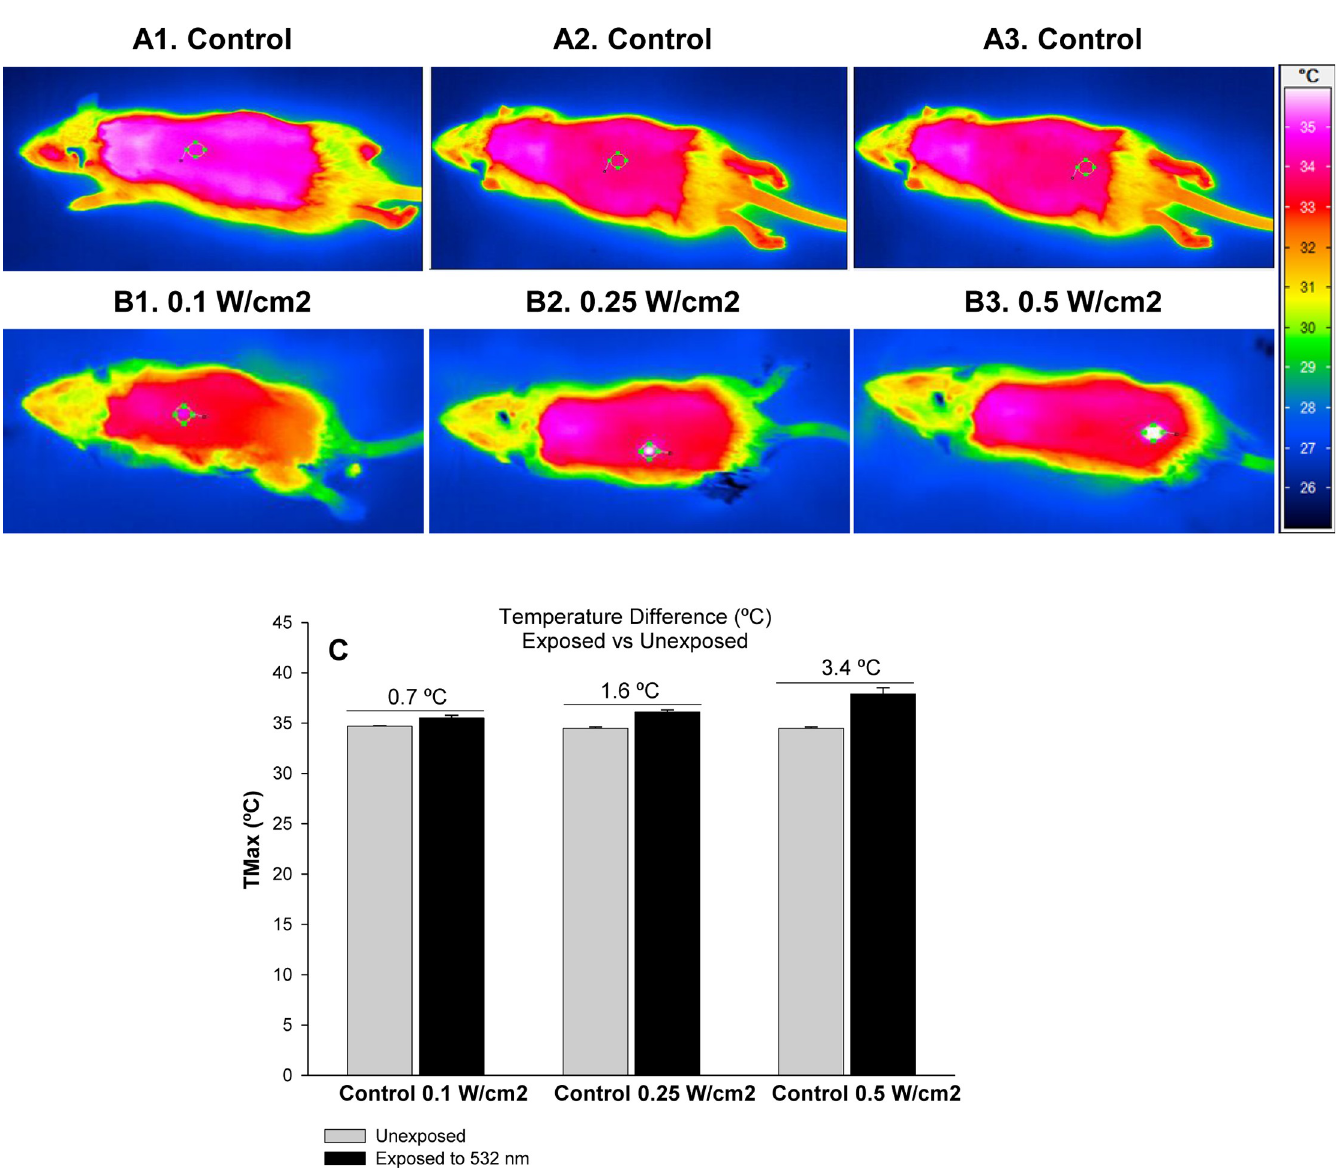
Fig 2. Morphometric analysis and thermal imaging of rat skin exposed to 532 nm laser. Thermogram of exposed rat skin to 532 nm laser at various fluences vs respective baseline thermogram is: 0.1 W/cm 2 (B1) vs A1, 0.25 W/cm 2 (B2) vs A2 and 0.5 W/cm 2 (B3) vs A3. Fig 1C shows Tmax data and temperature difference between exposed and unexposed rat